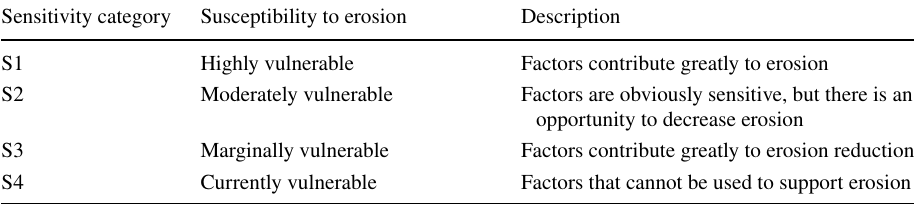
Table 1 FAO-based